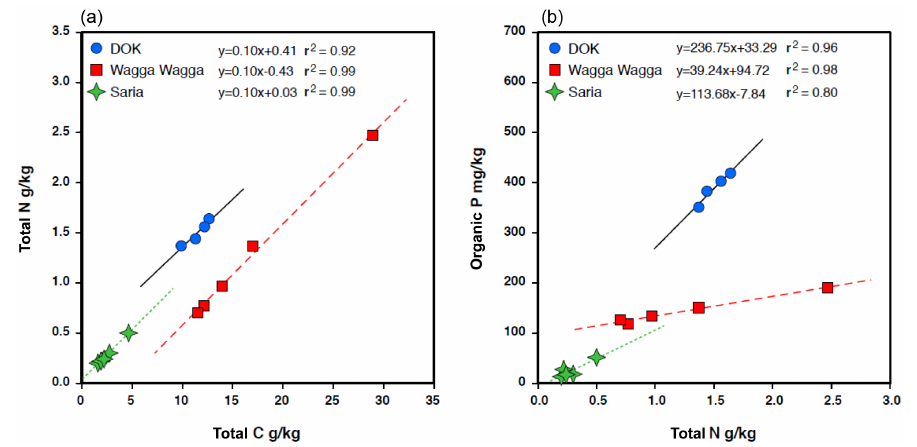
Figure 4. Relationships between soil C and soil N concentrations (a) and between soil N and soil organic P concentrations (b) in the three field experiments. Points in blue represent DOK, points in red represent Wagga Wagga, and points in green represent Saria. All relations are statistically significant at p < 0.05.